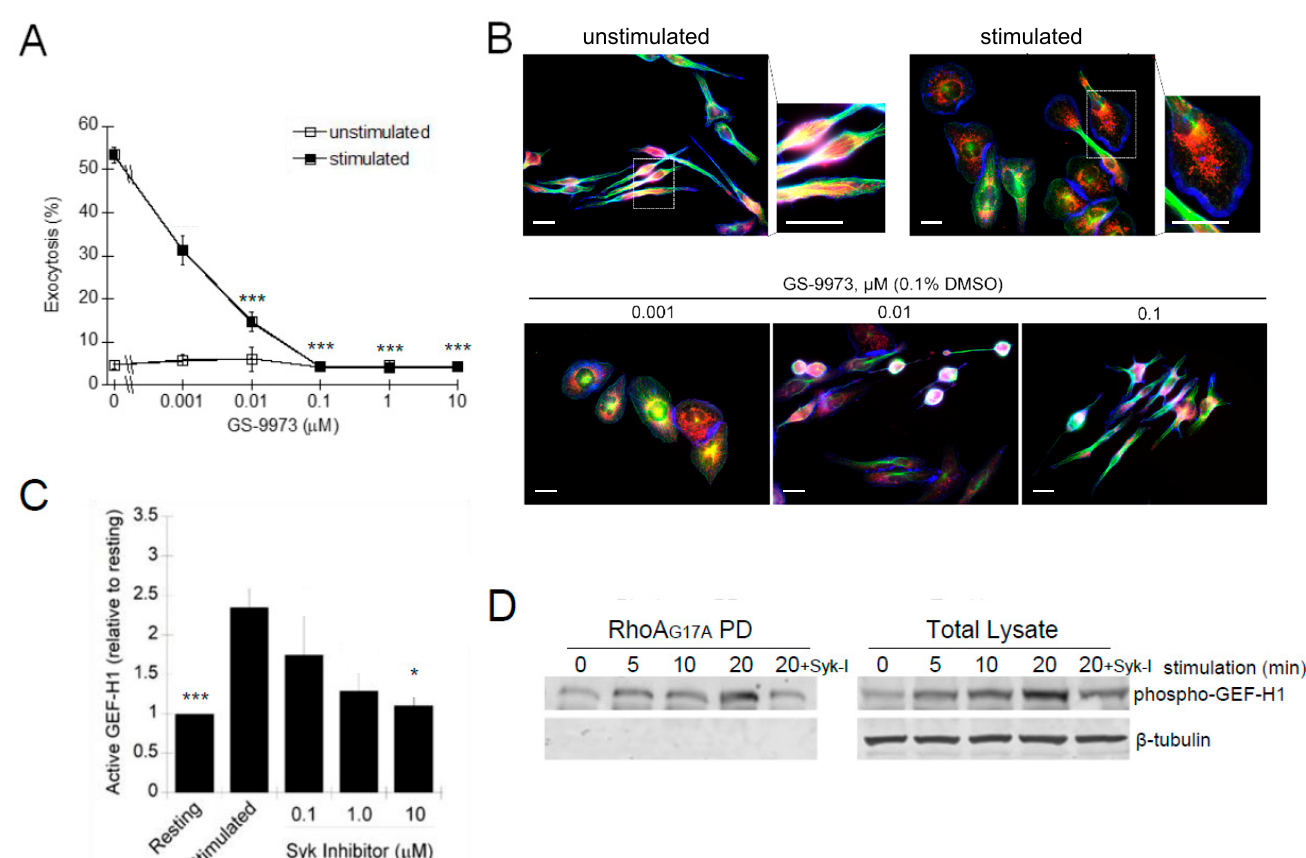
Figure 9. GEF-H1 activation is regulated by Syk-mediated phosphorylation. RBL-2H3 cells were preincubated for 20 min with 487 varying concentration of the Syk inhibitor, GS-9973, and its effect on antigen-stimulated exocytosis was examined by degranulation 488 assay and microscopy. ( A ) GS-9973 significantly reduced RBL-2H3 cell granule exocytosis ( *** p < 0.001 compared to DMSO control 489 by one-way ANOVA and post hoc Tukey’s test; n = 3 independent assays). ( B ) Images of cells preincubated with GS-9973 show 490 reduced cell spreading and granules remained in peri- nuclear regions. Cells were fixed and stained for granules with anti-CD63 491 antibody ( red ), micro- tubules with β -tubulin antibody ( green ) and F-actin with Alexa Fluor 405-phalloidin ( blue ). Scale bar = 20 µm. 492 ( C,D ) Active GEF-H1 levels were determined by GST-RhoA-G17A pulldown assays after antigen-stimulated for 20 min. ( C ) 493 GS-9973 reduced GEF-H1 activation in antigen-stimu- lated RBL-2H3 cells. Statistical analysis was performed by one-way ANOVA 494 ( * p < 0.001; n = 3 independent blots). Tukey’s tests were used to identify significant differences in pairwise compari- sons ( *** p < 0.001 495 resting vs stimulated; * p = 0.034 stimulated vs 10 µM Syk inhibitor). ( D ) Immunoblot of pulldown fractions and total lysates with 496 phospho-GEF-H1 (Ser886) antibody shows active GEF-H1 is phosphorylated with levels increasing up to 20 min of antigen stimula-497 tion; GS-9973 ( Syk-I ) reduced the levels of phospho-GEF-H1 in total lysates and pulldown fractions.